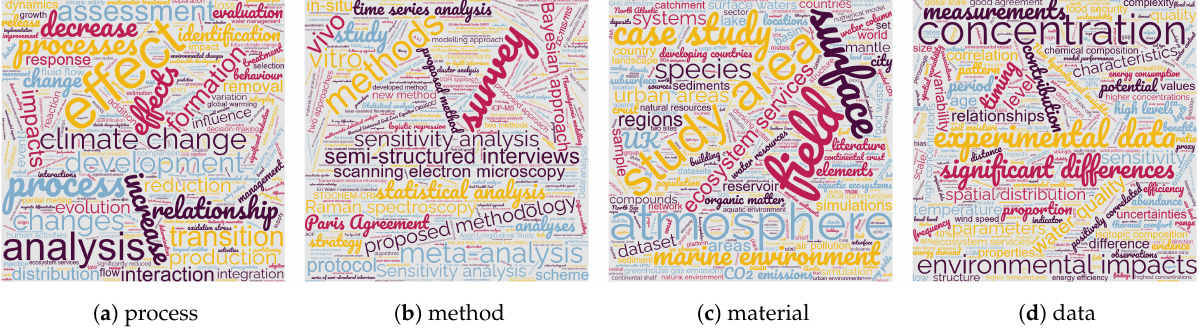
Figure 6. Earth Science domain word